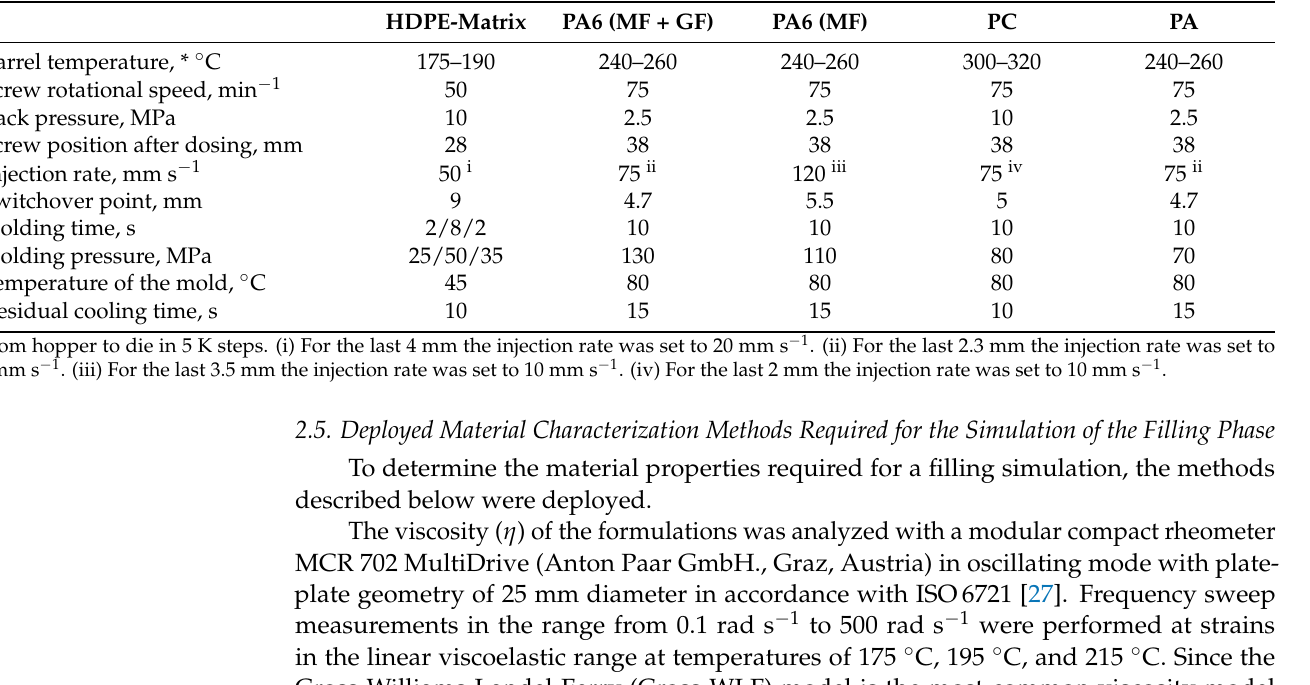
Table 4. Process settings on the injection molding